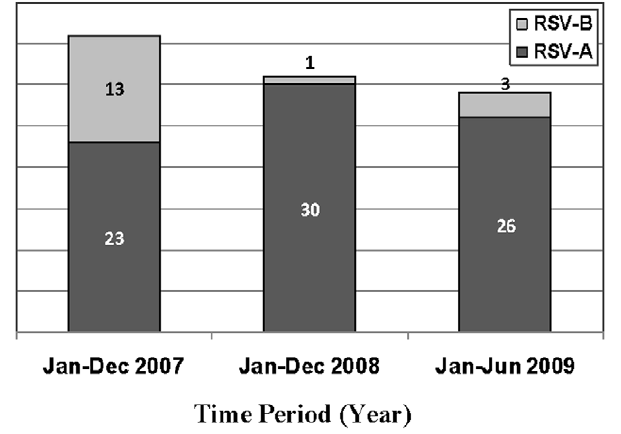
Figure 1. HRSV subgroups by Year. The number of samples for each HRSV subgroup (A and B) per year. For years 2007 and 2008, the month of collection are from January to December. For year 2009, the months of collection are from January to